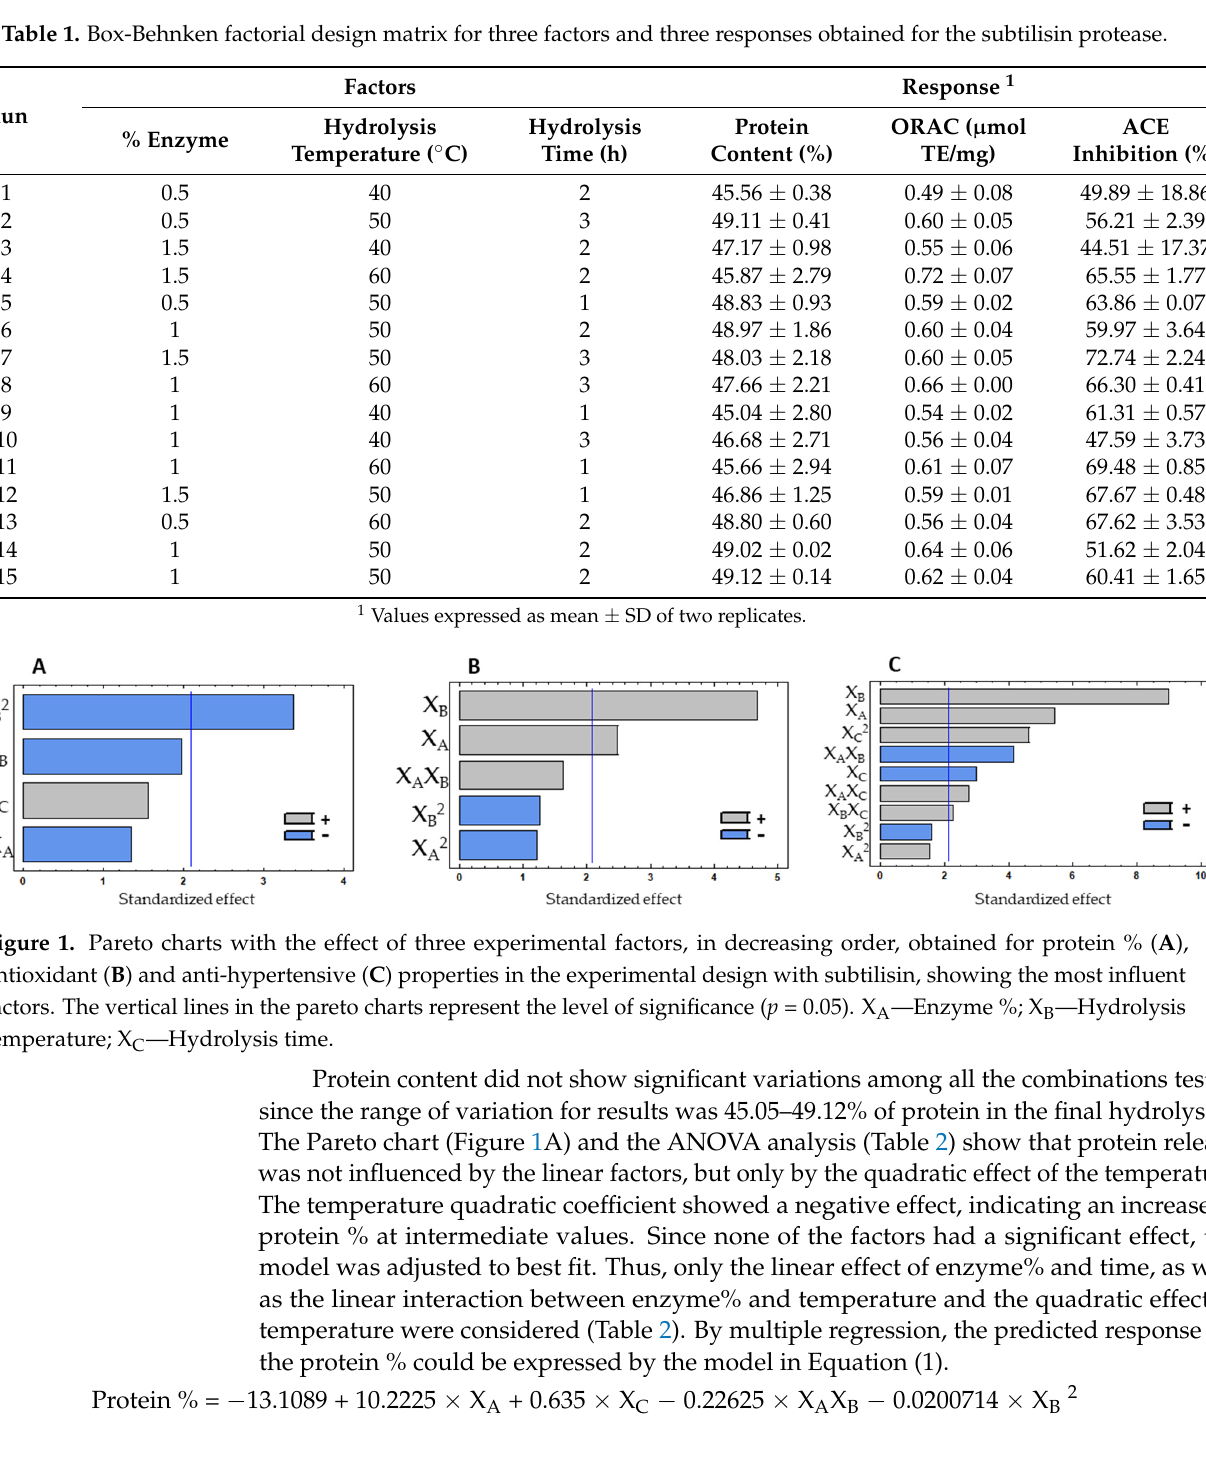
Table 1. Box-Behnken factorial design matrix for three factors and three responses obtained for the subtilisin protease.